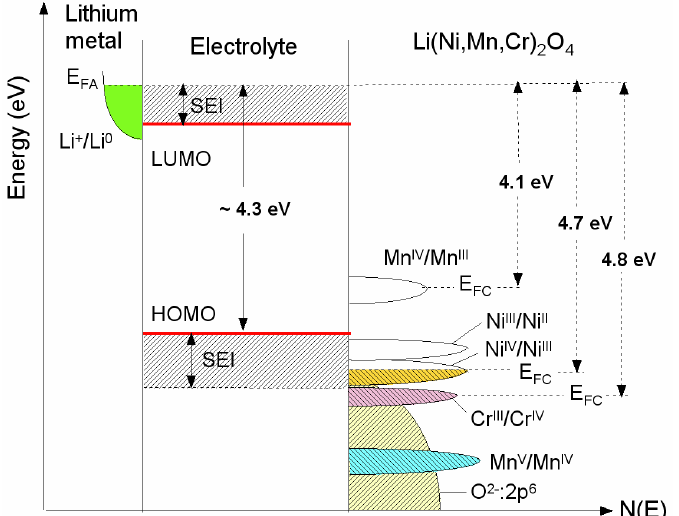
Figure 1. Schematic diagram showing the electronic density of states and Fermi energies solid electrolyte interface (SEI) layer formed on the electrode surface preserves the overall reversible